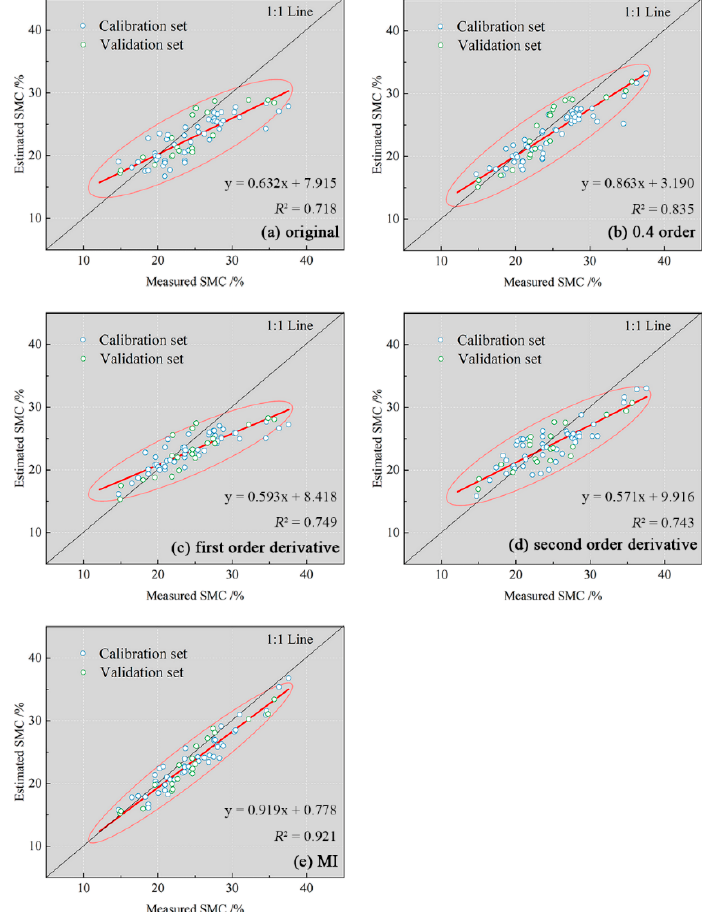
Figure 9. Scatterplots of the measured SMC and estimated SMC (representative model). The red area is a confidence ellipse of 95% confidence.